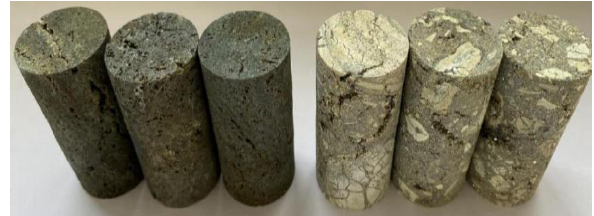
Figure 3. Specimens of triaxial compression test.